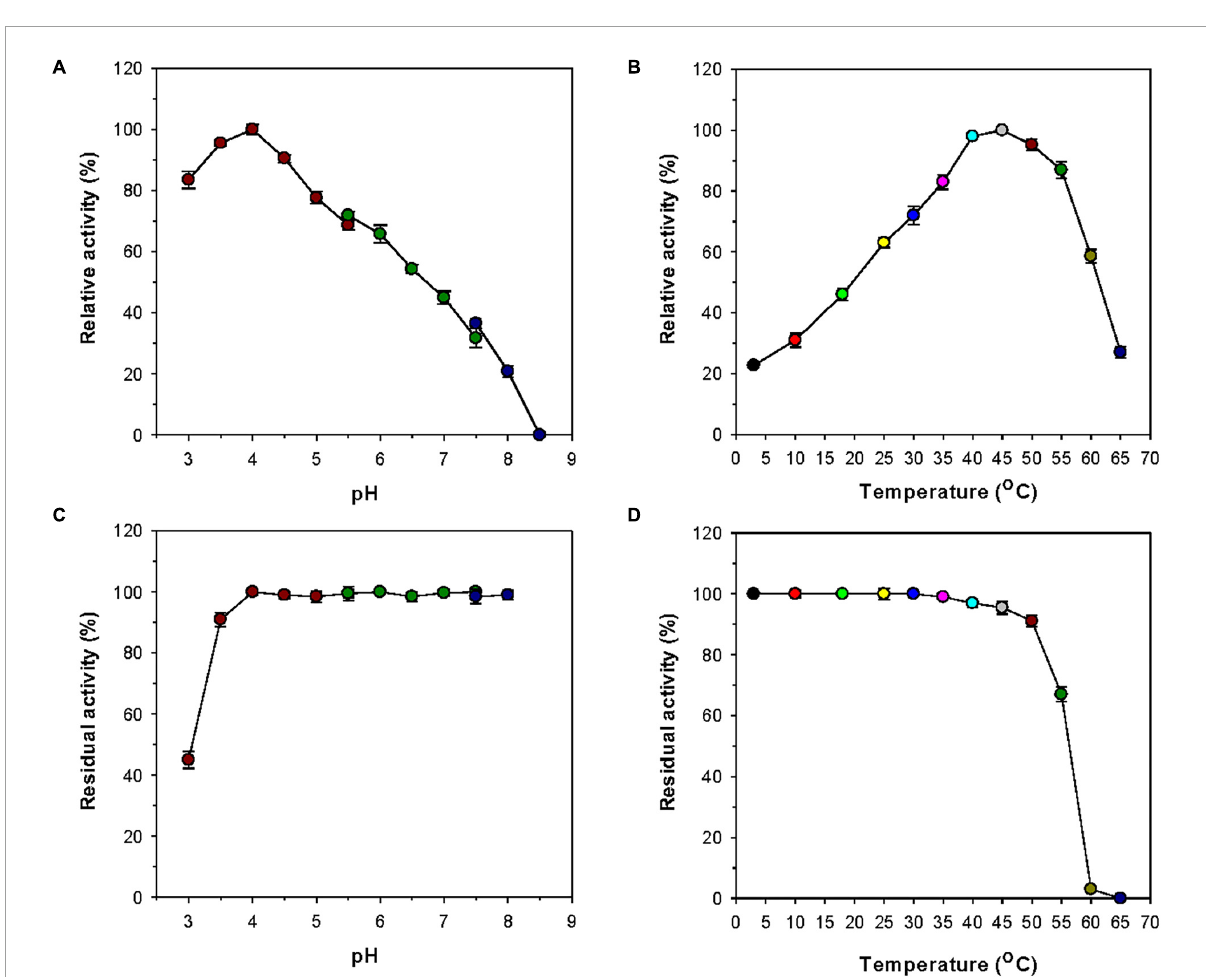
FIGURE4 Effects of pH (A) and temperature (B) on the endo- β -1,4-glucanase activity of rGluL and effects of pH (C) and temperature (D) on the stability of recombinant endo- β -1,4-glucanase (rGluL). The optimum pH of rGluL was investigated using the following buffers at 50 mM: sodium citrate (pH 3.0–5.5), sodium phosphate (pH 5.5–7.5), and Tris-HCl (pH 7.5–8.5). The optimum temperature of rGluL was determined at various temperatures (3–65 ◦ C) in 50 mM sodium citrate buffer (pH 4.0). The pH stability of rGluL was estimated by ascertaining the residual endo- β -1,4-glucanase activity after pre-incubation of the enzyme using the aforementioned buffer systems (50 mM) at 3 ◦ C for 1 h. The thermal stability of rGluL was examined by determining the residual endo- β -1,4-glucanase activity after pre-incubation of the enzyme at 3, 10, 18, 25, 30, 35, 40, 45, 50, 55, 60, and 65 ◦ C in 50 mM sodium citrate buffer (pH 4.0) for 1 h. The values are mean ± SD of triplicate